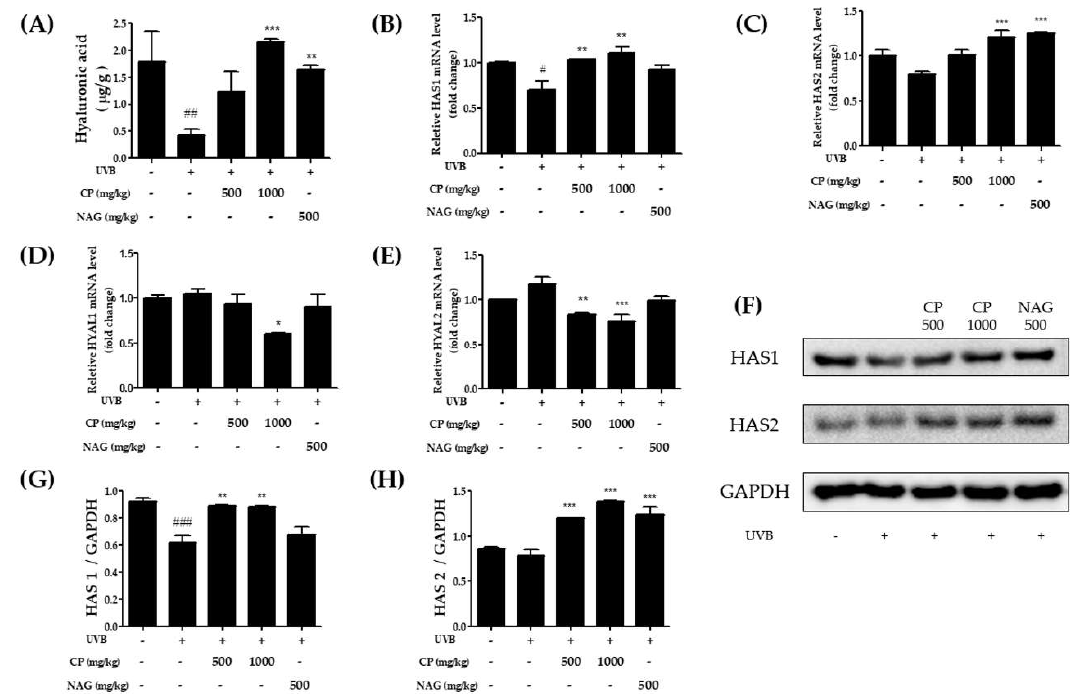
Figure 2. Effects of oral administration of collagen peptide on hyaluronic acid content, HAS isoenzymes, and hyaluronidase mRNA and protein expression in UVB-irradiated hairless mice. ( A ) Hyaluronic acid content in the dermis 9 weeks after UVB irradiation. mRNA levels of ( B ) HAS1, ( C ) HAS2, ( D ) HYAL1, and ( E ) HYAL2 were estimated by real-time PCR; ( F ) Western blotting and ( G , H ) relative densities of HAS1 and HAS2. The values are shown as mean ± SEM ( n = 8). # p < 0.05, ## p < 0.01, and ### p < 0.001 (vs. control mice). * p < 0.05, ** p < 0.01, and *** p < 0.001 (vs. UVB-irradiated mice).